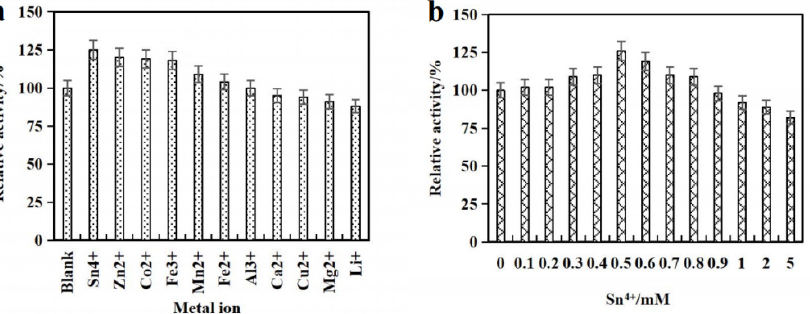
Figure 3. The effect of metal ion additives on the FAL-reducing activity ( a ); The influence of Sn 4+ dosage on the FAL-reducing activity ( b ).